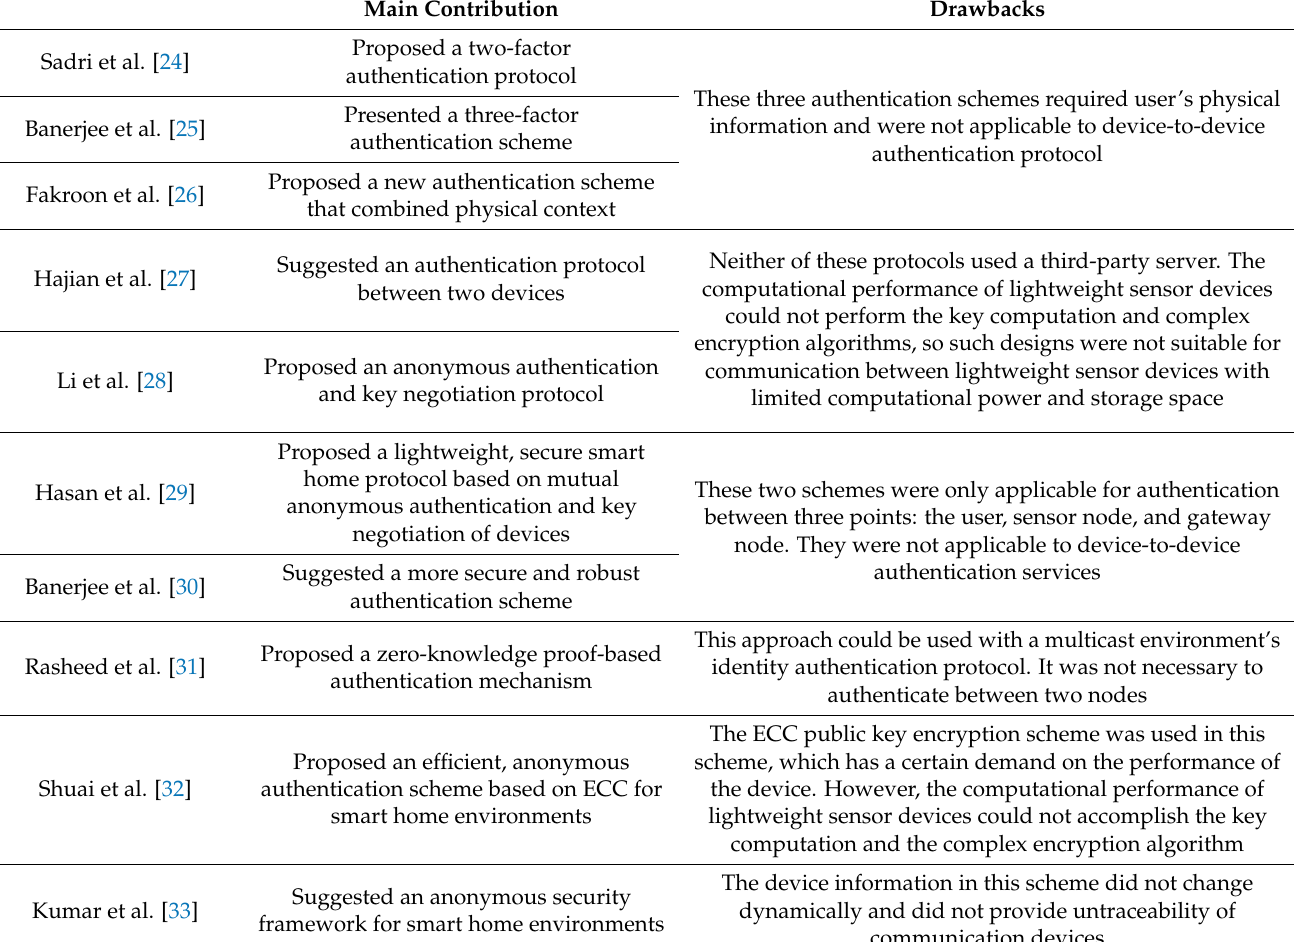
Table 1. Comparison of related